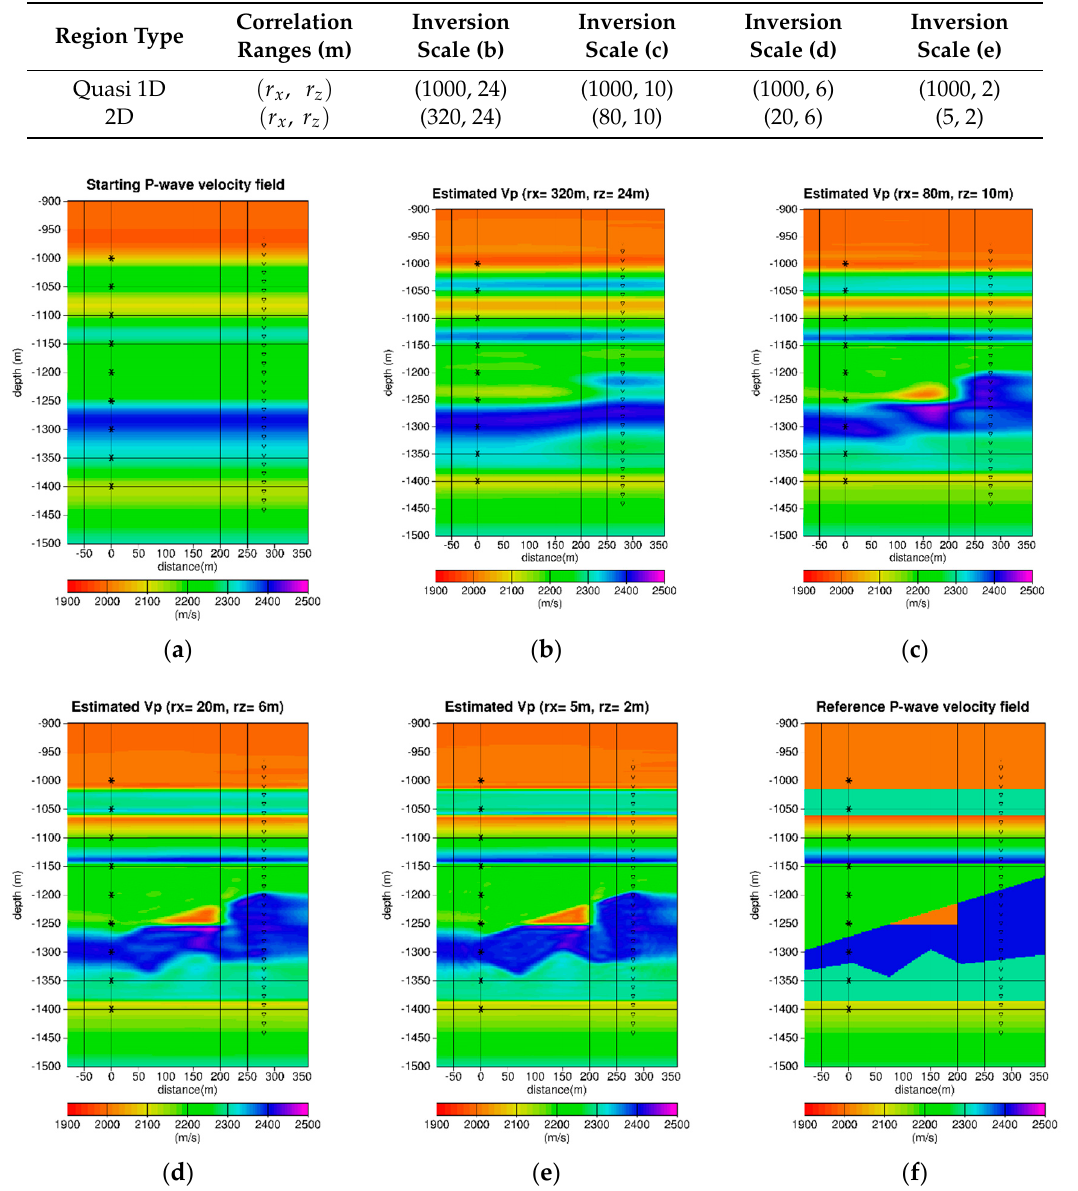
Figure 6. The results of the multiscale inversion process for the P-wave velocity field. Stars denote the source location while the small triangles denote the receiver location: ( a ) The P-wave velocity starting model; ( b ) the estimated P-velocity field obtained from the first inversion scale using correlation ranges of r x = 320 m and r z = 24 m in the 2D region; ( c ) the estimated P-velocity field obtained from the second inversion scale using correlation ranges of r x = 80 m and r z = 10 m in the 2D region; ( d ) the estimated P-velocity field obtained from the third inversion scale using correlation ranges of r x = 20 m and r z = 6 m in the 2D region; ( e ) the estimated P-velocity field obtained from the fourth and last inversion scale using correlation ranges of r x = 5 m and r z = 2 m in the 2D region; ( f ) the reference P-wave velocity model. The results for the first scale of the inversion do not allow recovery of the 2D structures, as the correlation ranges are greater than the size of the objects. The 2D structures start to appear from the second scale, improving from the third scale, and are well recovered for the last